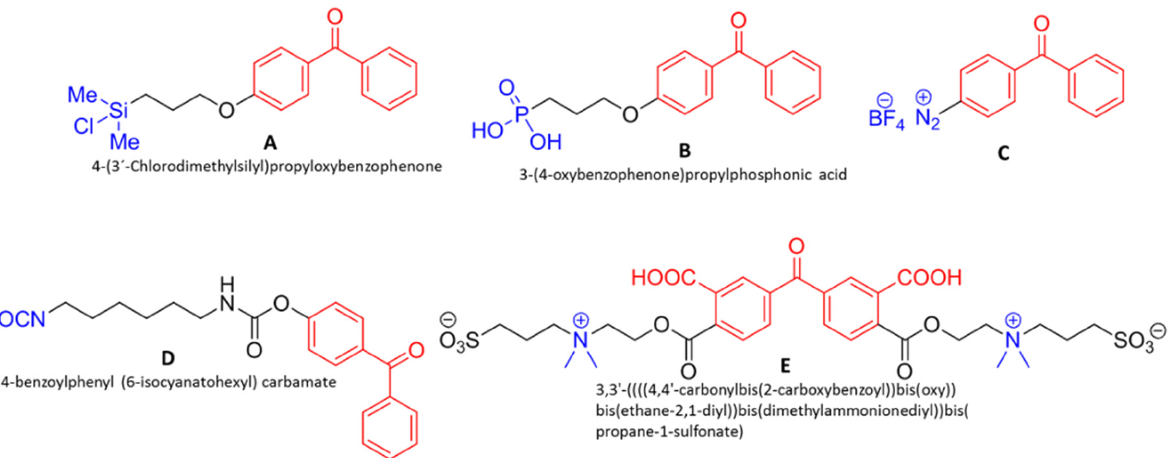
Figure 7. BP derivatives with different coupling units (photosensitive groups are labeled in red; anchor moieties are labeled in blue).